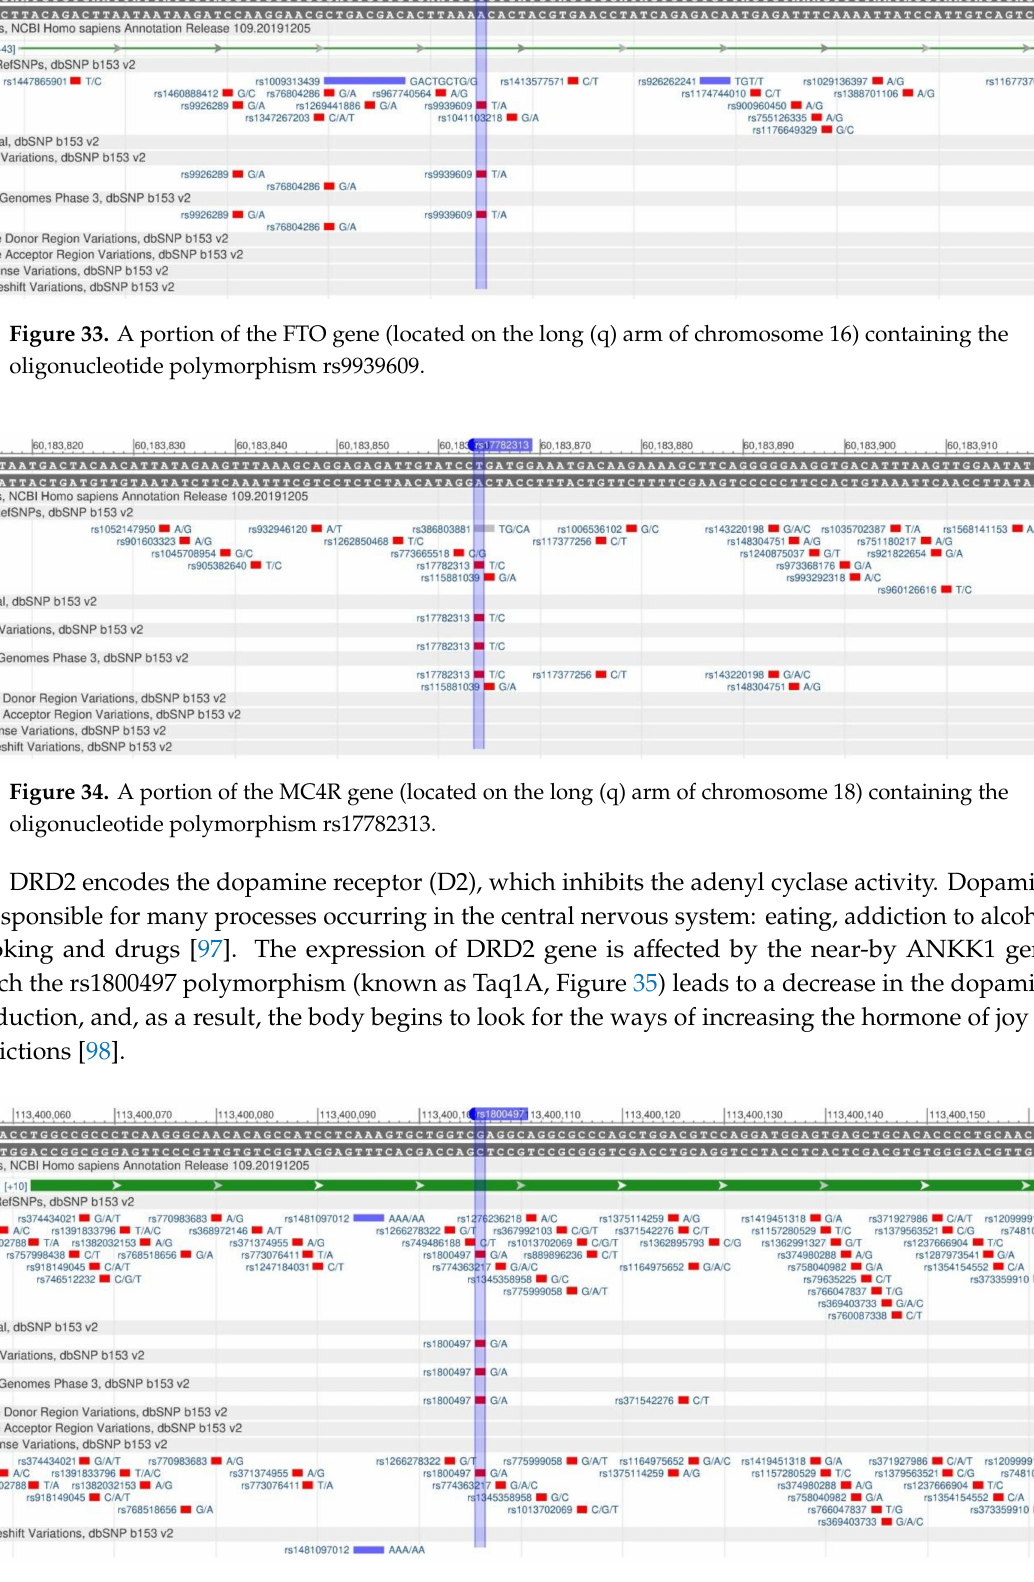
Figure 35. A plot of the DRD2 gene (located on the long (q) arm of chromosome 11) containing the oligonucleotide polymorphism